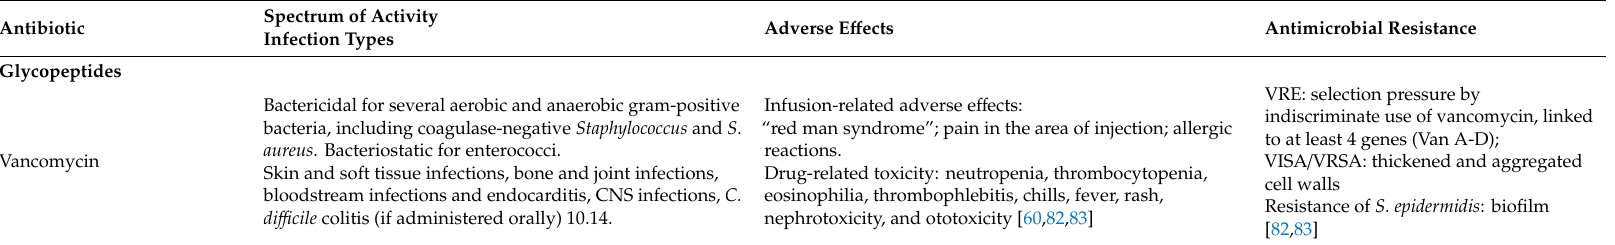
Table 2. Spectrum of activity and infection types, adverse e ff ects and antimicrobial resistance for the considered